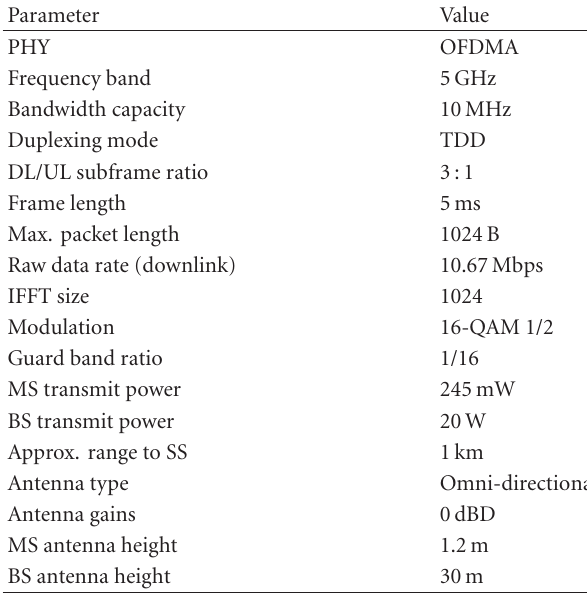
Table 1: IEEE 802.16e parameter